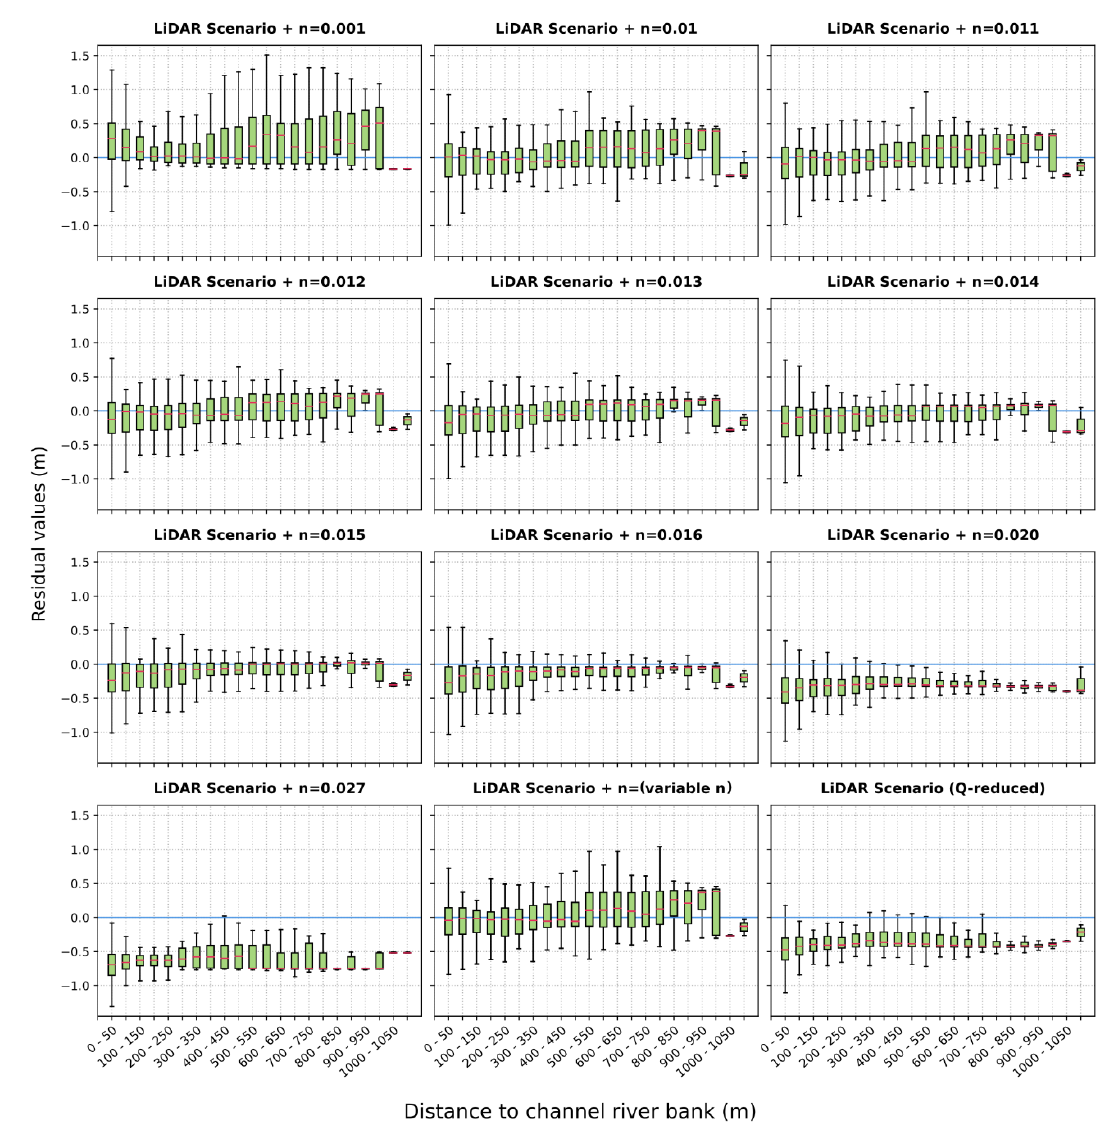
Figure 7. Box plot graphics showing the relationship between the flow depth errors and the distance to the riverbank (within 50 m intervals). Positive errors were related to the underestimation of the flow depth value by the calibrated model, and vice versa.